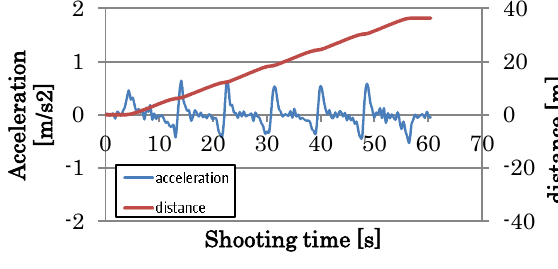
Fig. 7 X-axis acceleration and position of camera